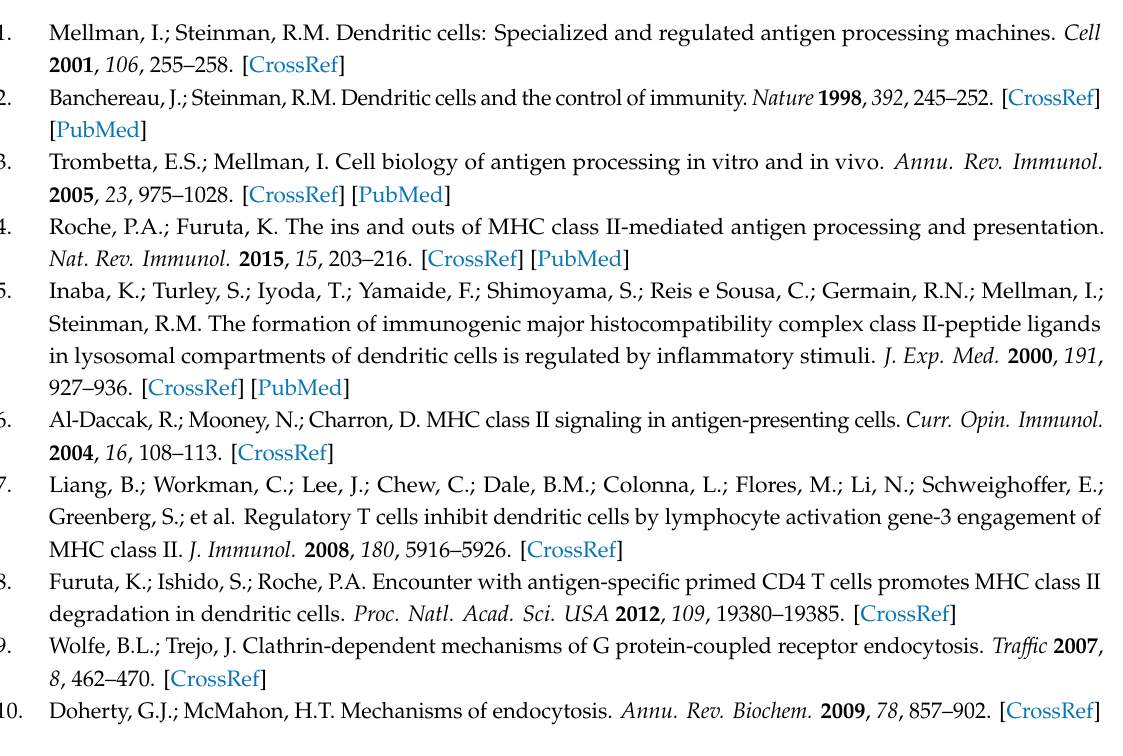
Figure S1: E ff ect of crosslinking and BAPTA-AM on endocytosis of